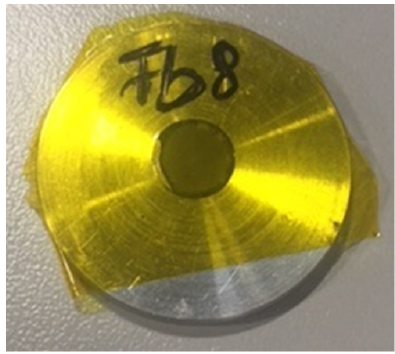
Figure 1. Sample holder (Al flat plate) with the electrode specimen (dark disk at the center) sealed with Kapton tape in an Ar-filled glove box.